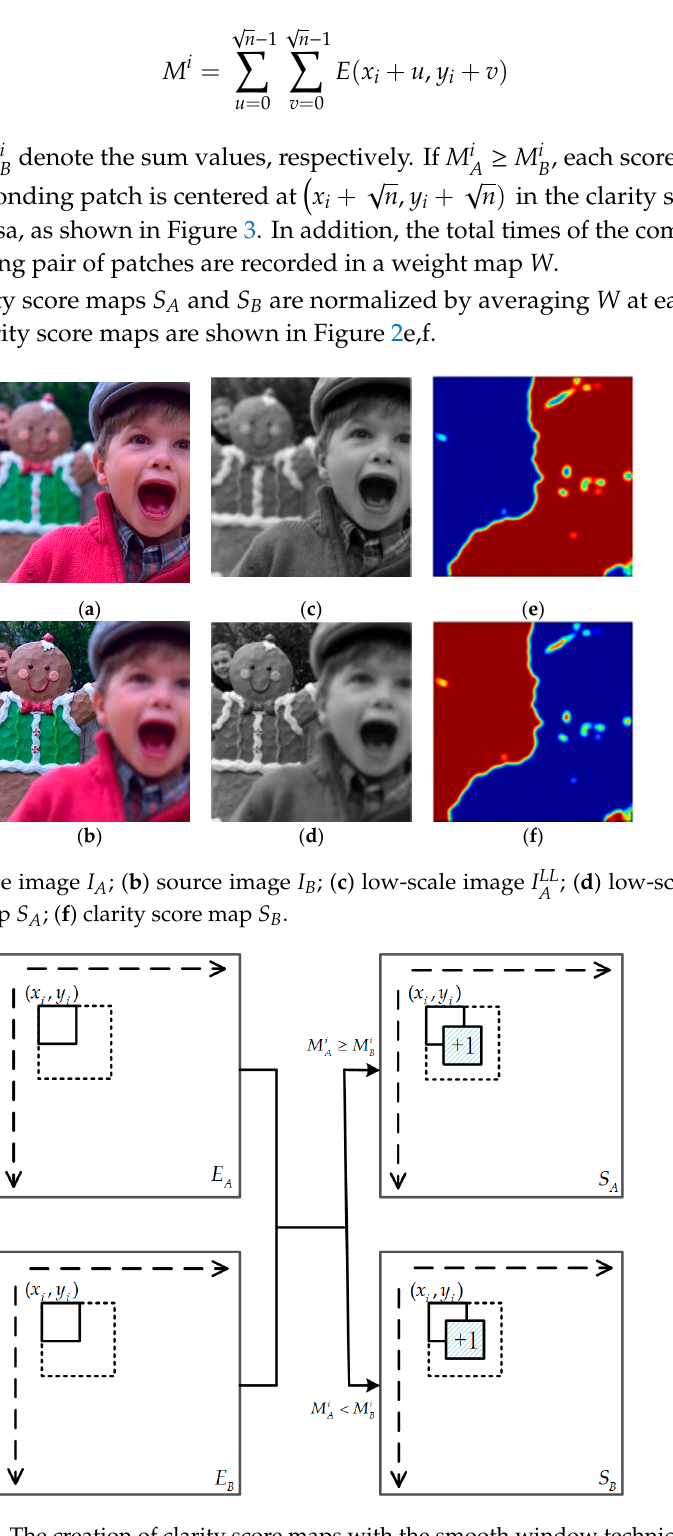
Figure 3. The creation of clarity score maps with the smooth window technique.